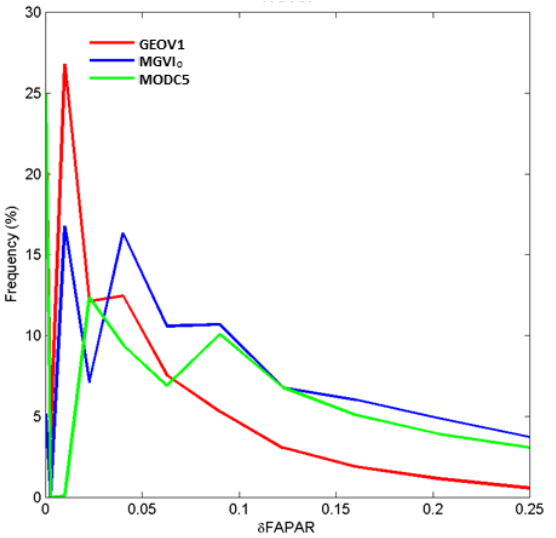
Figure 6. Distribution of the smoothness metrics (δFAPAR) computed for GEOV1 (red), MGVIo (blue) and MOD.C5 (green). Computation is performed over the BELMANIP2.1 sites (49 × 49 km 2 ), during the periods defined in Table 2, and for the original temporal